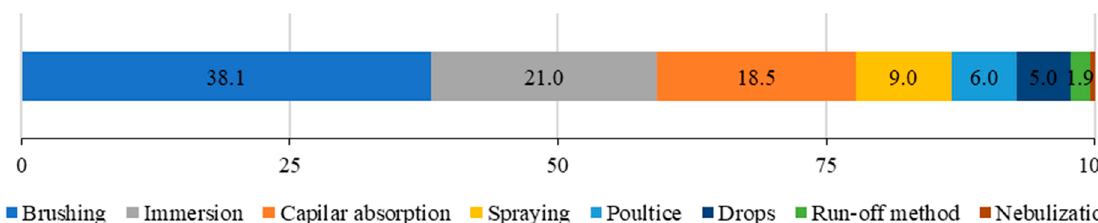
Figure 3. Distribution of the application methods used in stone consolidation research.